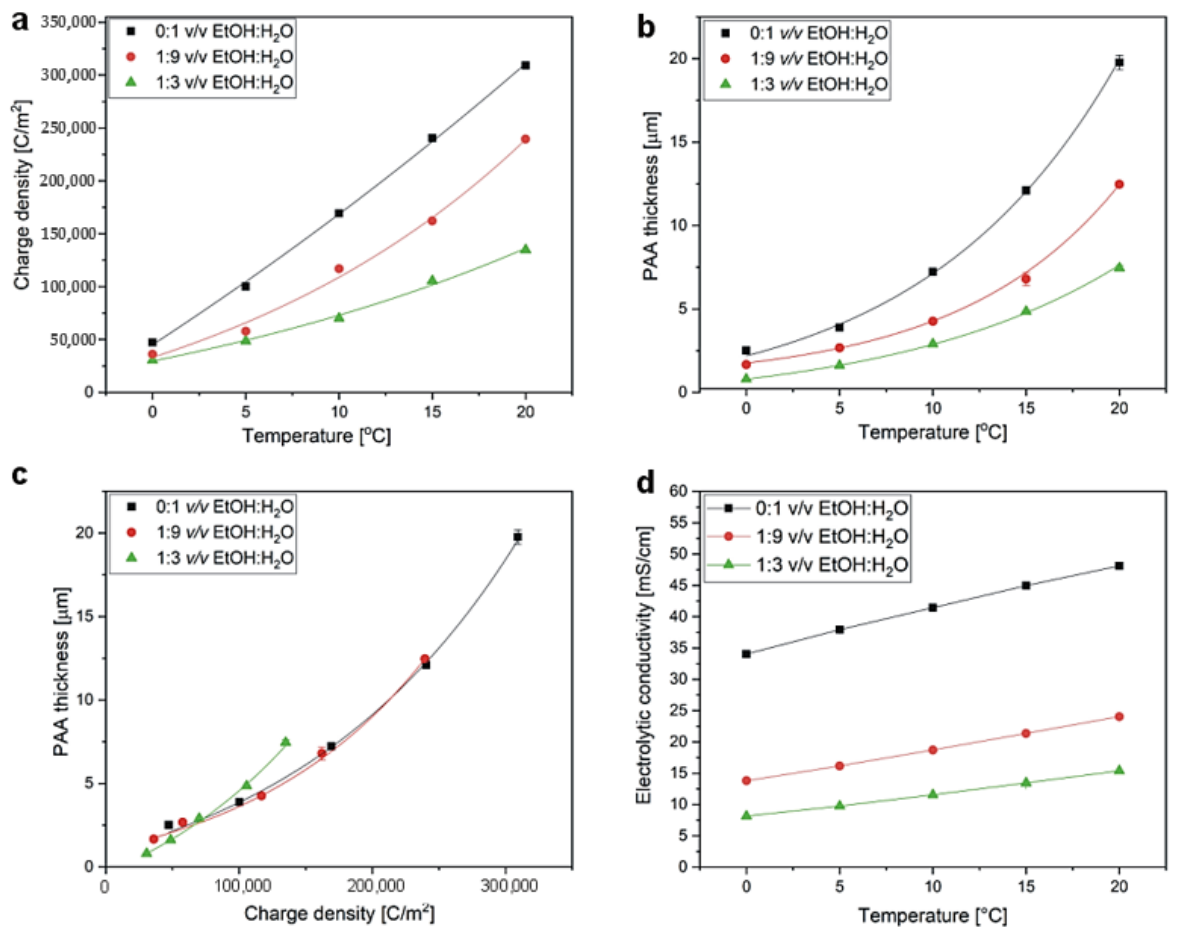
Figure 9. Charge density ( a ) and PAA thickness ( b ) vs. anodizing temperature; PAA thickness vs. charge density ( c ); and electrolytic conductivity of 0.3 M etidronic electrolytes of different composition vs. temperature ( d ).